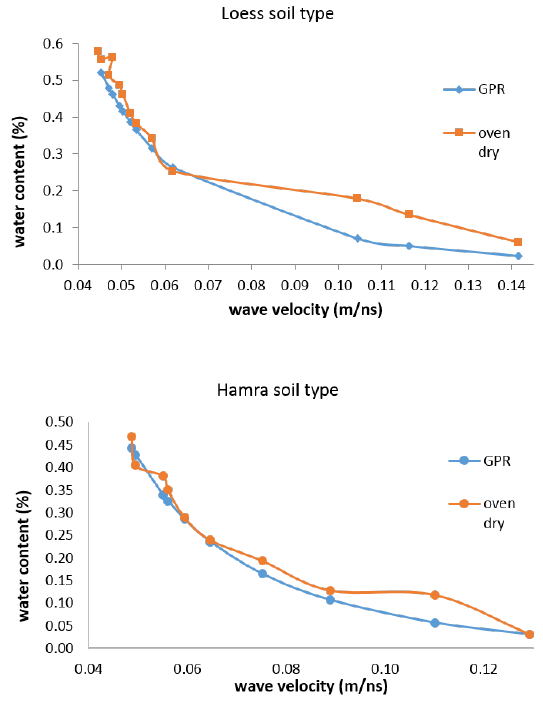
Figure 8. Measured GPR and oven-dry moisture content as a function of the electromagnetic wave velocity. The measured calibration data were collected with a 1 GHz GPR antenna on